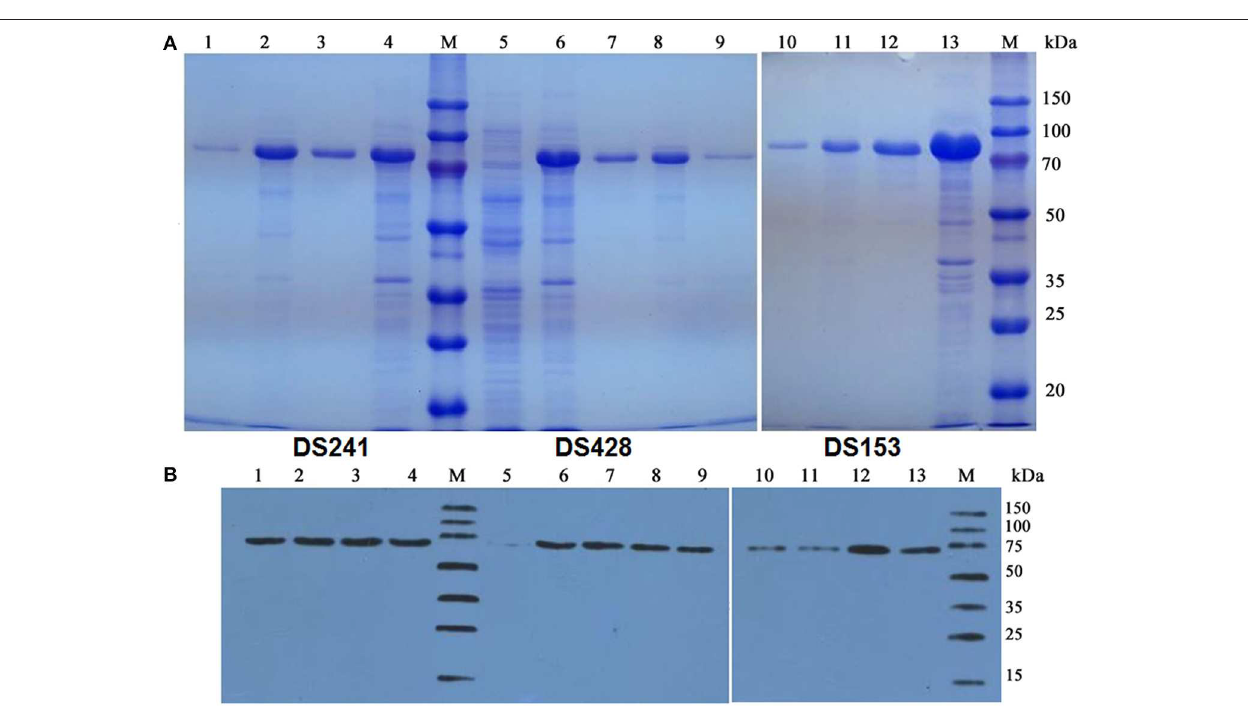
FIGURE 2 | SDS-PAGE (A) and Western blot (B) analysis of mutant xylanases. M: standard protein marker; Lane 1, 9, and 10 were purified protein of DS241, DS428, and DS153 by Ni 2 + -chelating affinity chromatography, respectively; Lane 2, 8, and 11 were ultrasonication supernatant of DS241, DS428, and DS153 induced by IPTG, respectively; Lane 3, 7, and 12 were fermentation supernatant of mutant DS241, DS428, and DS153 induced by IPTG, respectively; Lane 4, 6, and 13 were cells of DS241, DS428, and DS153 induced by IPTG, respectively; Lane 5 was E. coli BL21 harboring the pCold TF vector induced by IPTG